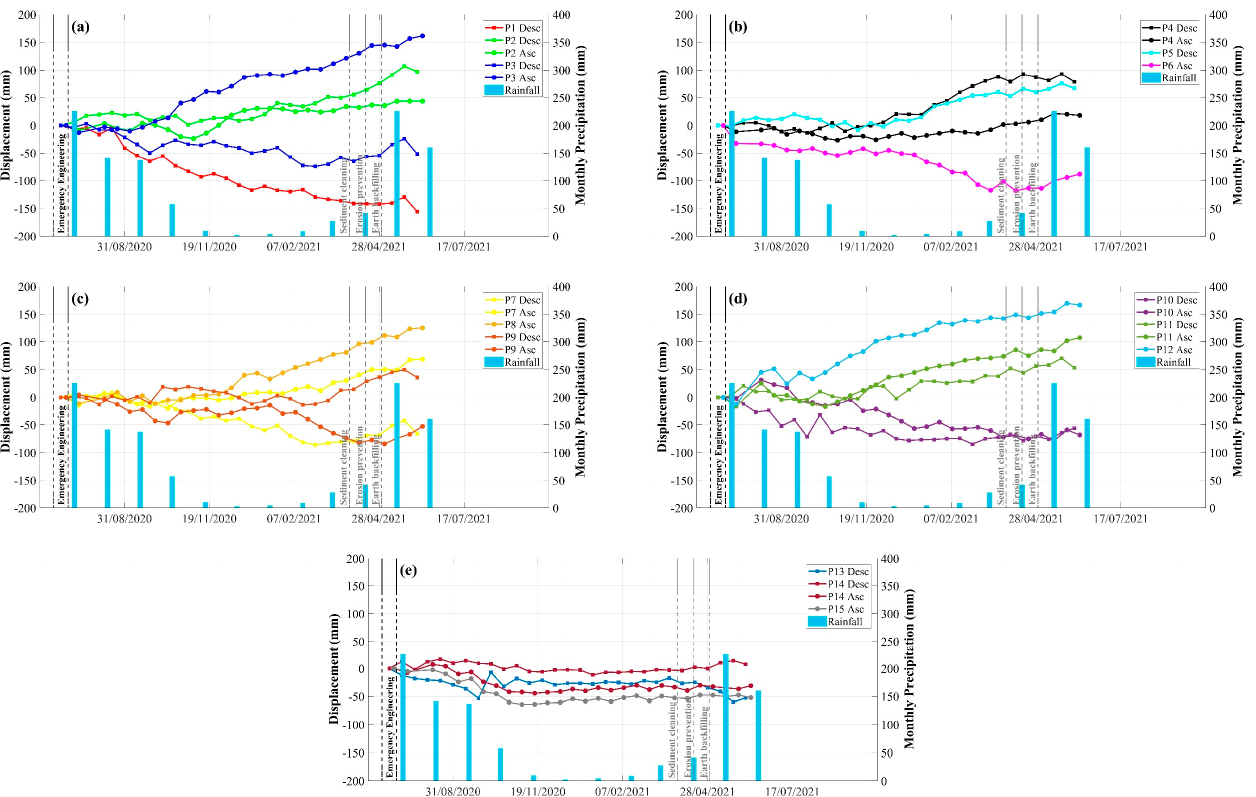
Figure 5. Post-failure time series plotting for selected measurement points from the different zones. ( a ) Central (I) zone; ( b ) Toe (II) zone; ( c ) Upstream (III (cid:48) ) zone; ( d ) Upper slope (IV) zone; ( e ) Unstable slope in the post-failure mean velocity map (Figure 4). Note that the black dashed lines indicate the period of emergency engineering, and the grey dashed lines indicate the completion date of each activity in the on-going remediation engineering